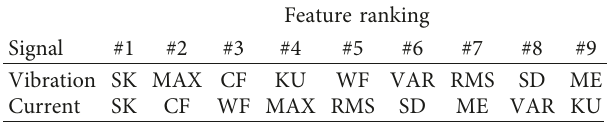
Table 3: Feature selection by the RFE. Feature